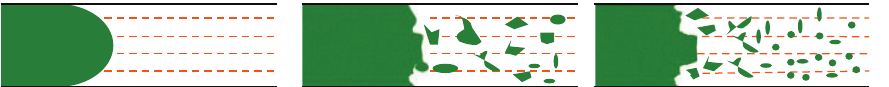
Figure 1: The formation process of DPG in peristaltic pump.